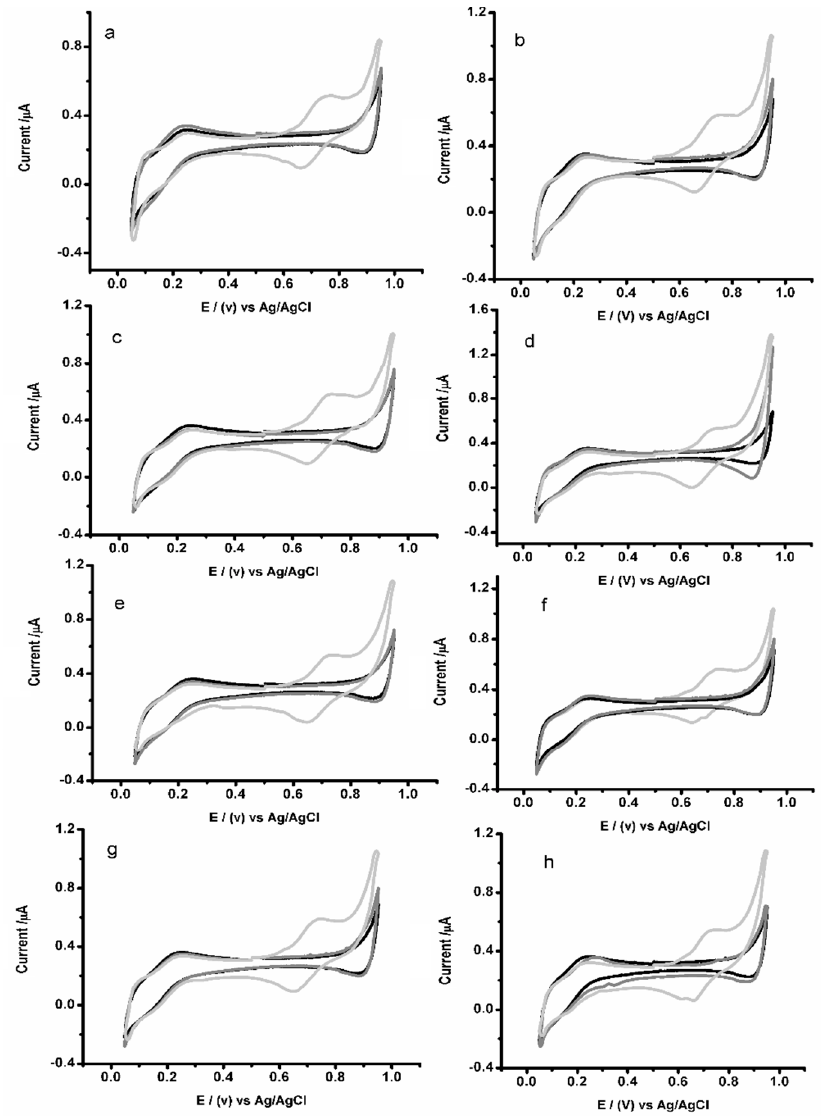
Figure 5. Influence of the individual interfering substances at micro-ITIES arrays, background-subtracted CVs of 40 µ M DCF − (black line), 40 µ M DCF with the interfering substances (dark grey line), and 40 µ M DCF with the interfering substance (5.0 mM) and 120 µ M TMA + (light grey line). The interfering substances selected: ( a ) L-ascorbic acid, ( b ) D-glucose, ( c ) NaCl, ( d ) KCl, ( e ) urea, ( f ) Na 2 SO 4 , ( g ) glycine, and ( h ) PBS solution without the interfering substance (control). The concentration of interfering substance in all experiments was 5.0 mM and at scan rate 10 mVs − 1 .